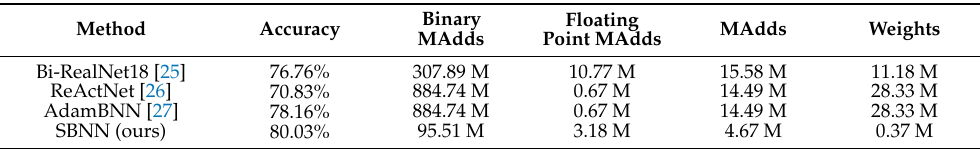
Table 9. The comparison with modern computer vision binary networks in the three-categories SAR ship classification task.